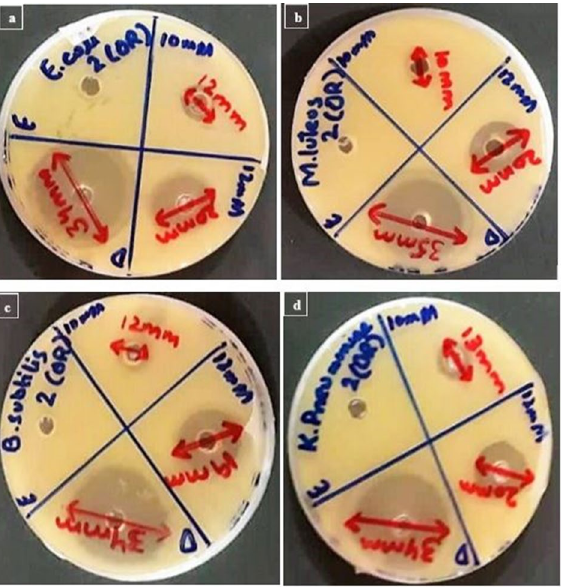
Figure 5. Antimicrobial activity analysis of SeNPs synthesized from Citrus paradisi (Grapefruit) fresh peels extract against bacterial pathogens; ( a ) E. coli , ( b ) M. luteus , ( c ) B. subtilis , ( d ) K. pneumoniae .